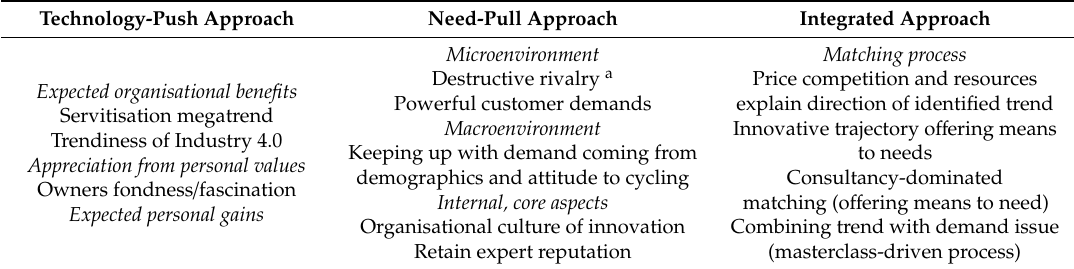
Table 11. Collective overview of the observed Industry 4.0 adoption